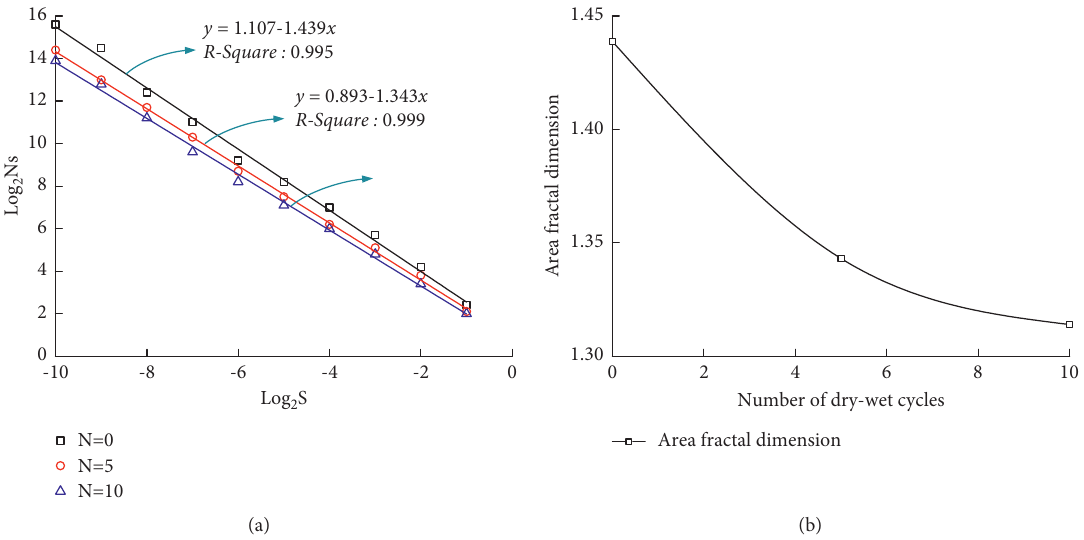
Figure 10: Change curves of the fractal dimension of the weakly cemented sandstone fracture area with different numbers of dry-wet cycles. (a) Fitting curves. (b) Fractal